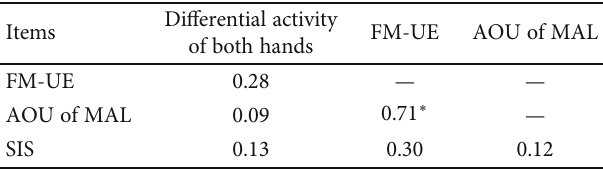
Table 2: The correlations between FM-UE, AOU of MAL, SIS, and di ff erential activity of both